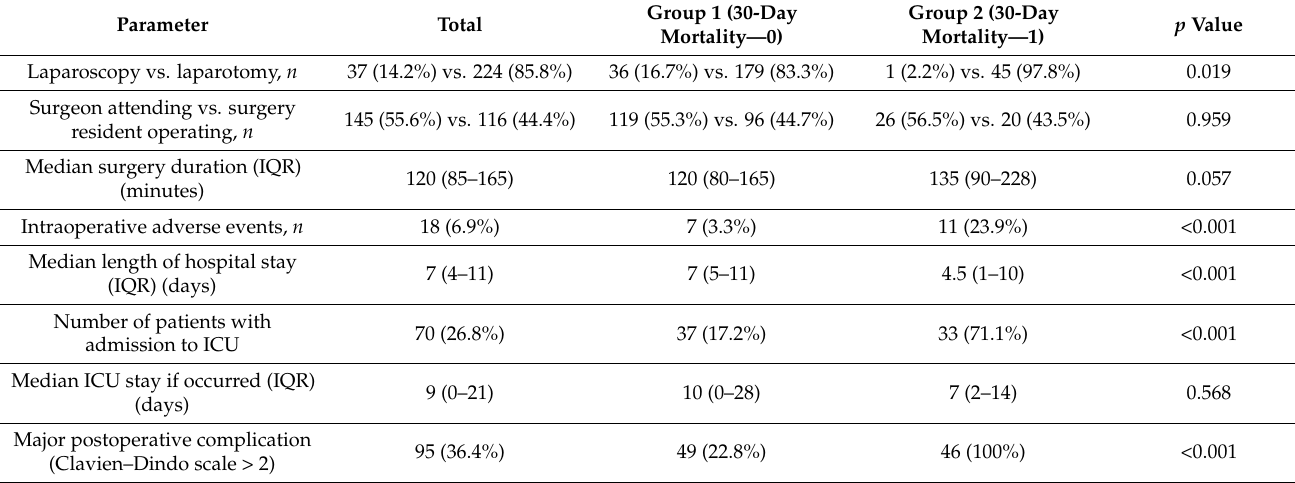
Table 2. Perioperative outcomes of study groups.